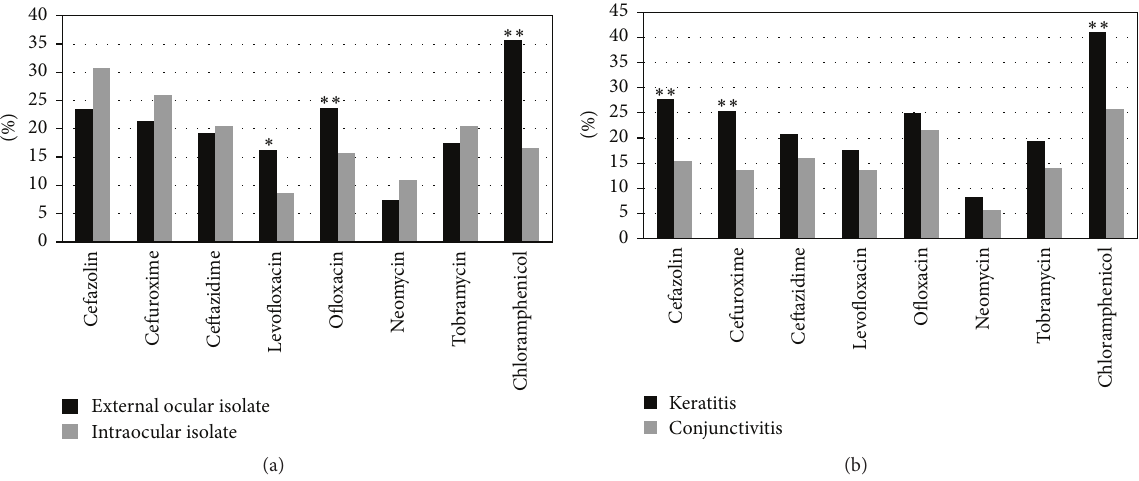
Figure 1: The drug-resistance of bacteria isolates from different ocular tissues to eight antibiotics. (a) Comparison of external ocular (black) and intraocular (gray) bacteria isolates; (b) comparison of cornea (black) and conjunctiva (gray) isolates. ∗ 𝑃 < 0.05 , ∗∗ 𝑃 < 0.01